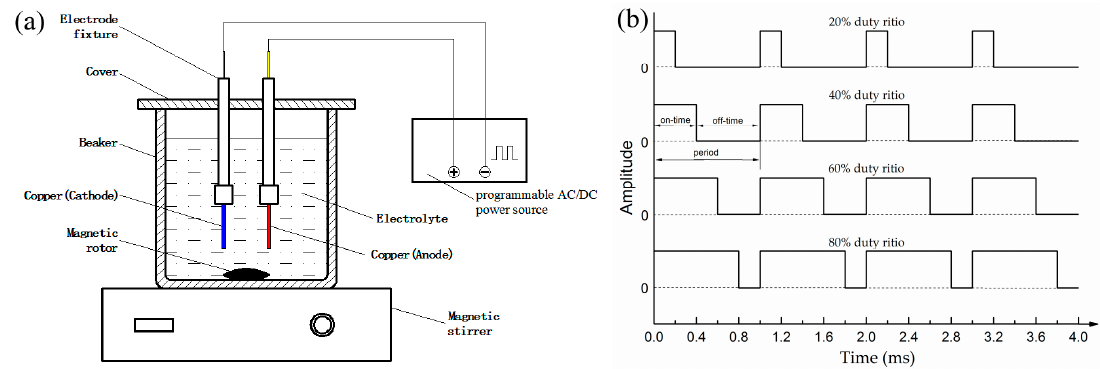
Table 1. Electrolytic and electrical parameters.